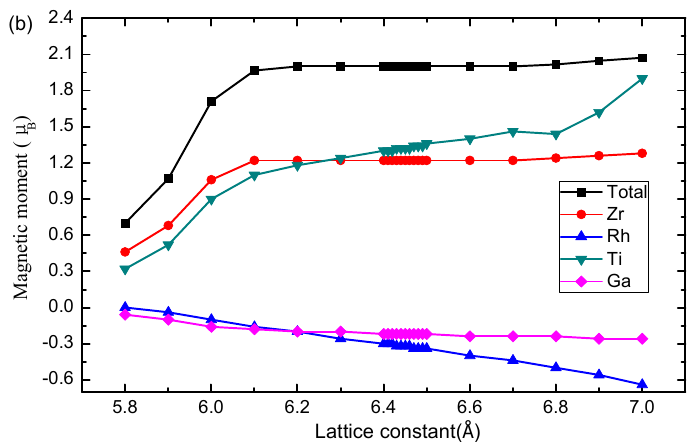
Figure 6. Plots for total spin magnetic moment and atomic spin magnetic moment as a function of lattice constant for ZrRhTiAl ( a ) and ZrRhTiGa ( b ) compounds. Appl. Sci. 2018 , 8 , x